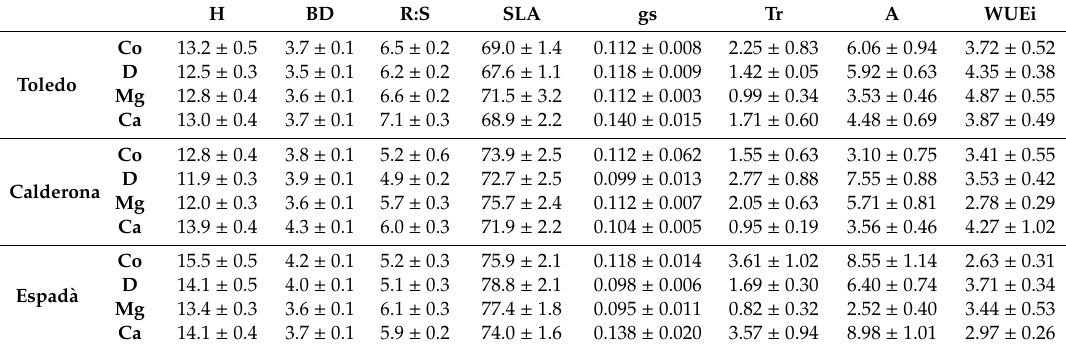
Table 1. Trait values (mean ± SE) of 11-month old cork oak ( Quercus suber ) seedlings from three populations in response to drought and soil chemistry (Co, control; D, drought; Mg, MgCO 3 inputs; Ca, CaCO3 inputs) (see Table 2 for the statistical analysis). H BD R:S SLA A WUEi